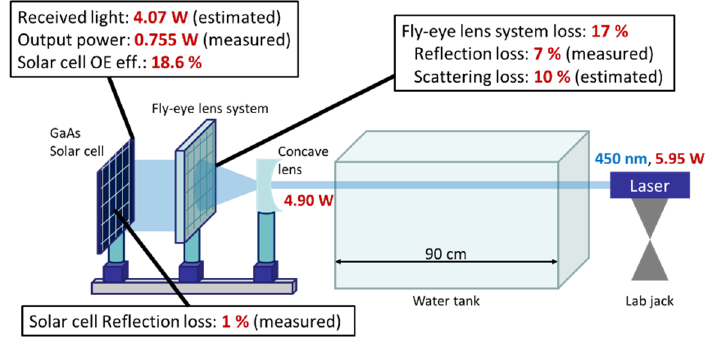
Figure 6. Power transmission efficiency in underwater OWPT.